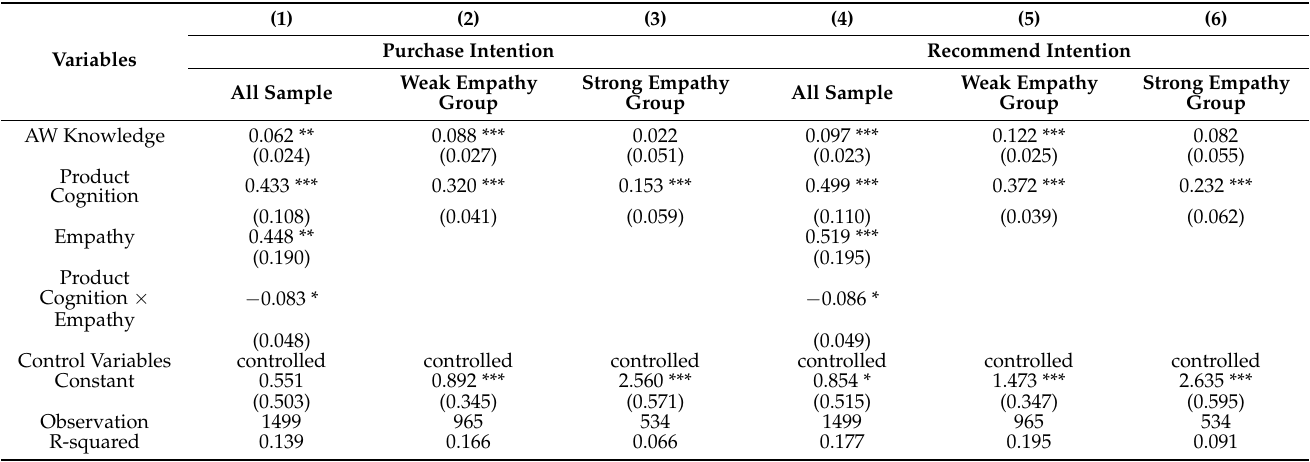
Table 9. Moderating effects of